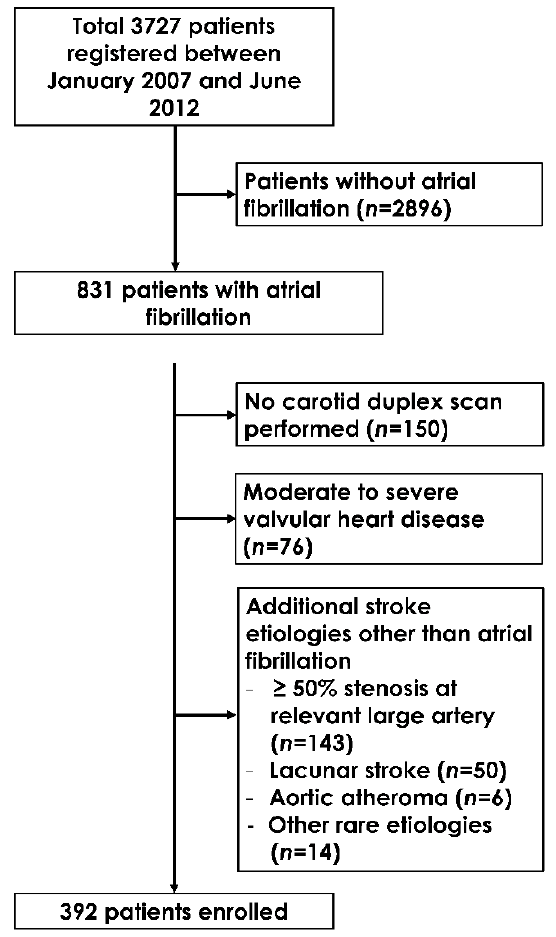
Figure 1. Flow sheet for study patients’ selection.